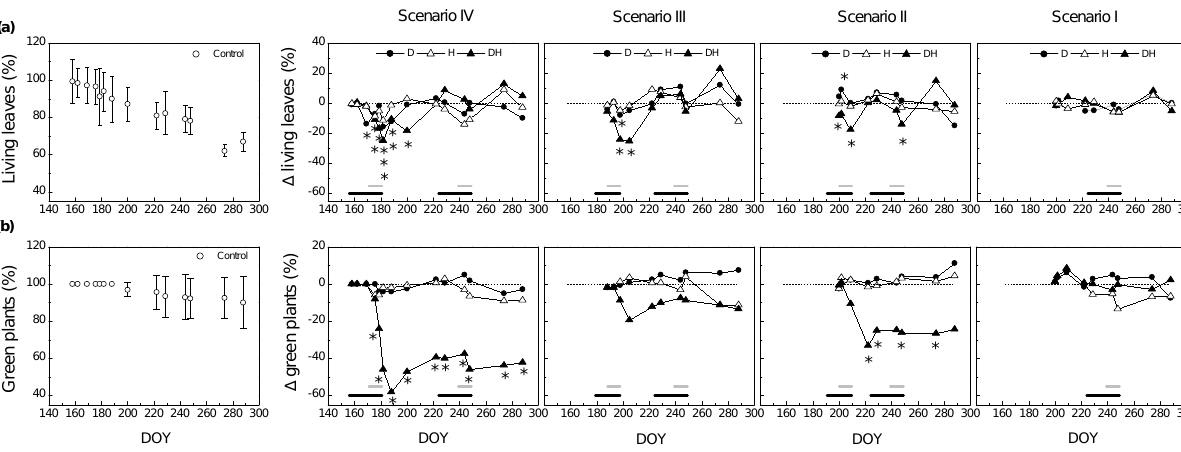
Fig. 2. Course of (a) the percentage of living leaves, and (b) the percentage of green plants for the whole plant community. Control val- ues are given (left panel) and the difference between the controls and the treatments during the different scenarios. Standard errors are displayed for the controls but are not shown for the other treatments for improved clarity. D = drought (closed circles), H = heat (open trian- gles), DH = drought + heat (closed triangles). Bottom lines in each graph indicate timing of the climate events (black line = drought, grey line = heat wave). Asterisks, arranged in the same vertical order as the points, indicate significant differences ( P < 0 . 05) between treatments and control on that day. DOY = day of year.